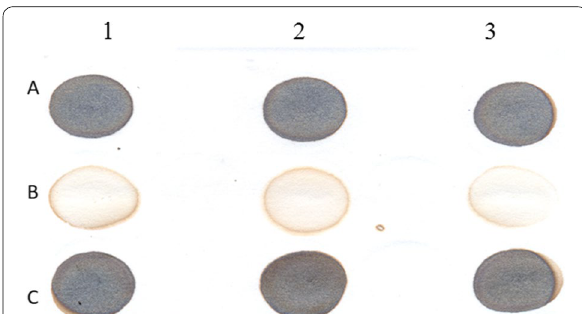
Fig. 4 Hydrogen sulfide production by the P. indica H32 at 24 h of culture in the H medium. 1, 2 and 3 number of replicas. A: P. indica H32. B: Negative control (H medium). C: Positive control ( Brevibacterium celere C924, active component of the HeberNem ® registered biological product for the nematode control and plant growth